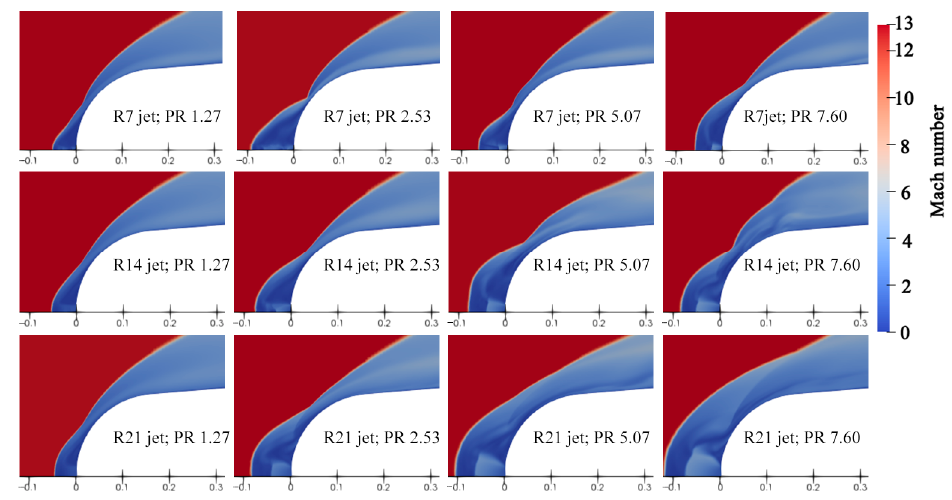
Figure 12. Jet modes of R7, R14, and R21 jets with the same PR.